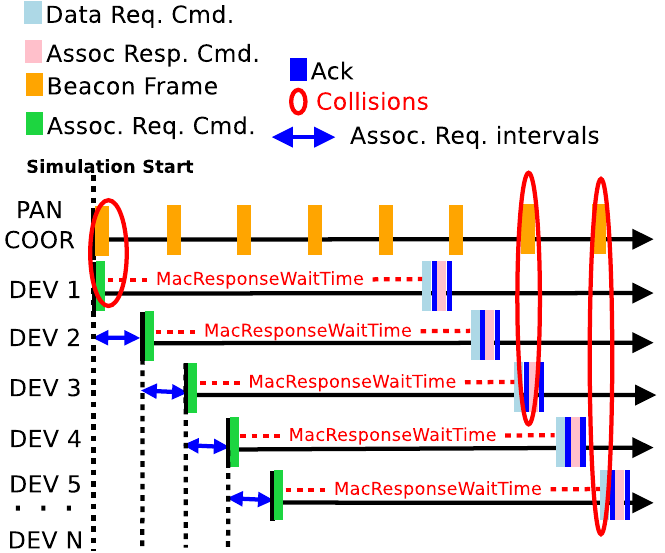
Figure 12. Association command frames overlap.